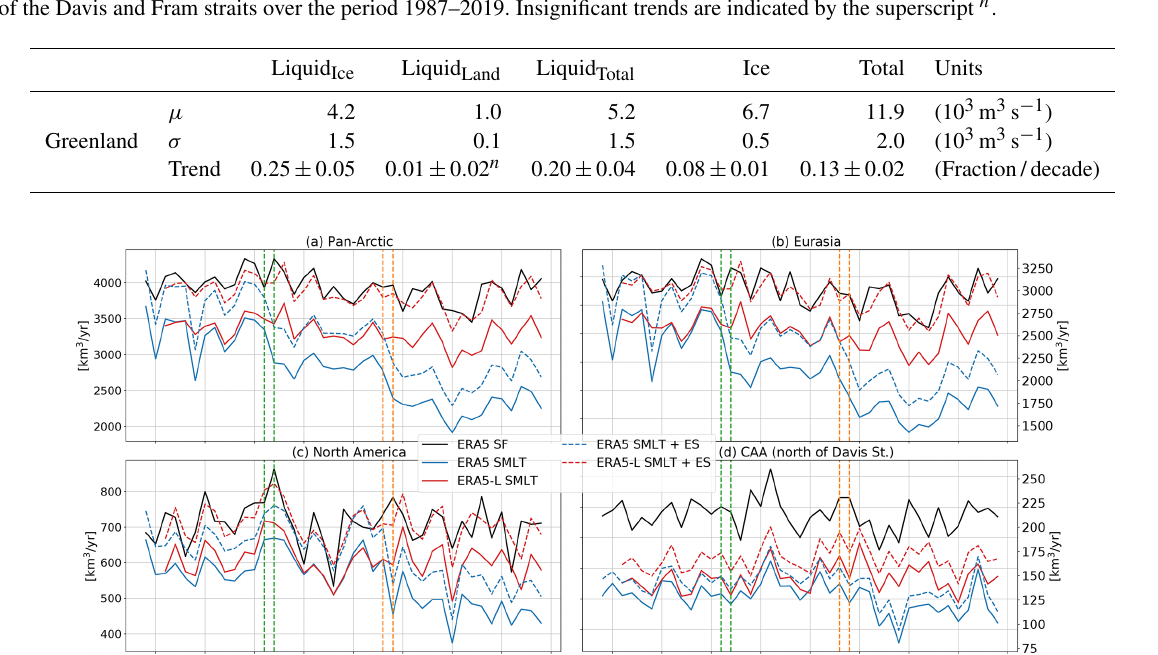
Table 7. Mean values, standard deviations, and trends for liquid discharge from ice and land as well as solid ice discharge for Greenland north of the Davis and Fram straits over the period 1987–2019. Insignificant trends are indicated by the superscript n .